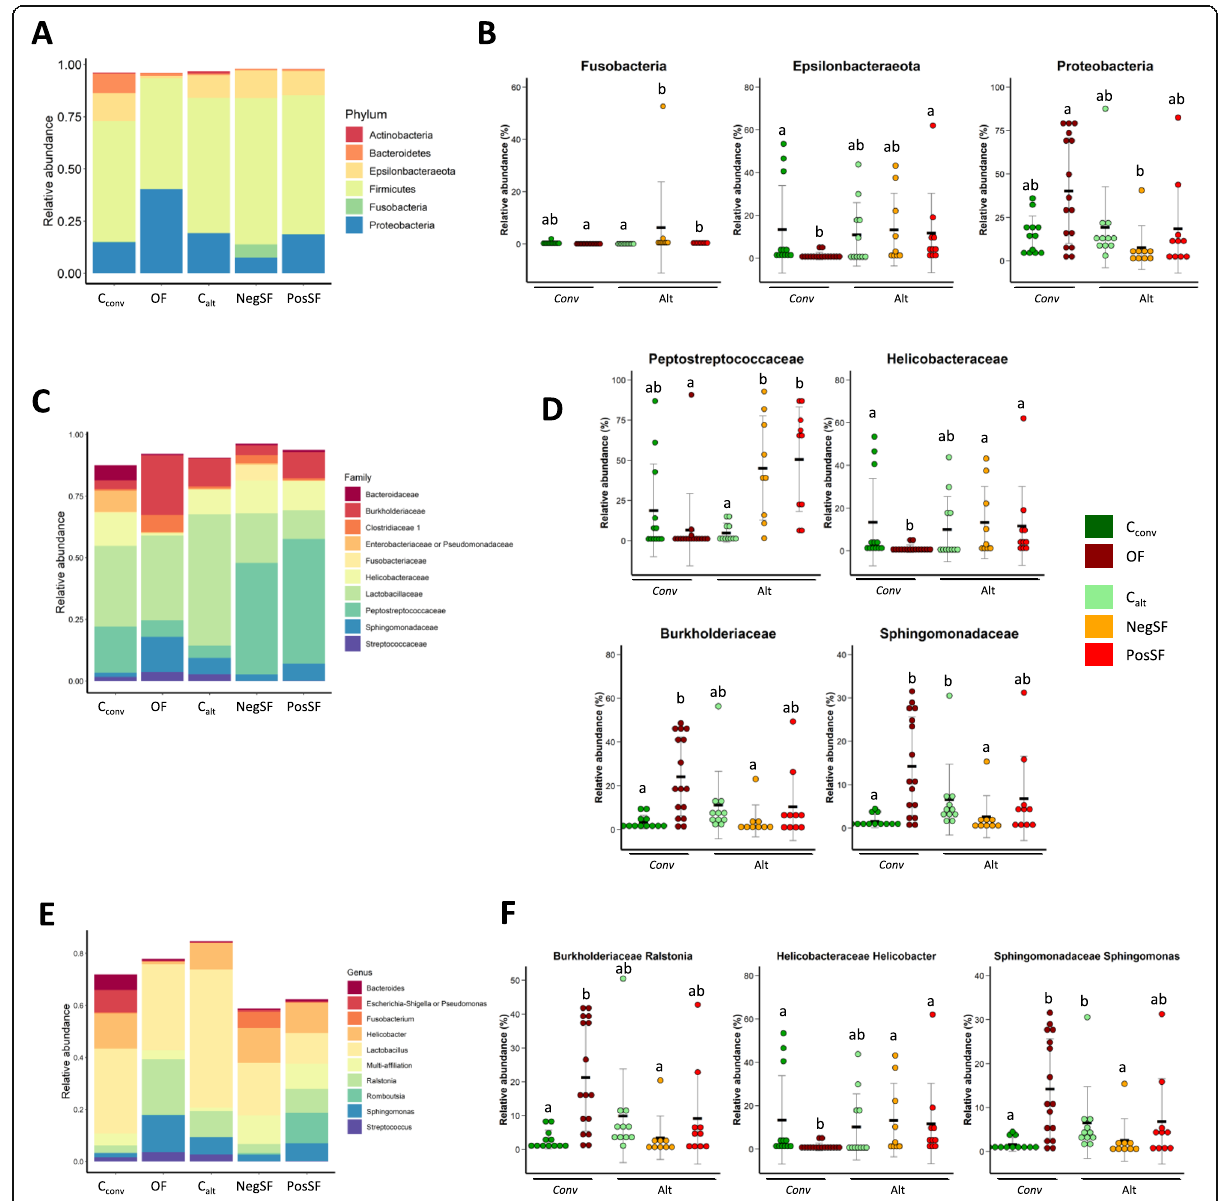
Fig. 5 Microbial composition according to the experimental groups at ( a-b ) Phylum, ( c - d ) Family and ( e - f ) Genus level. In panels ( c ) and ( e ) only the 10 most abundant Families ( c ) and Genera ( e ) are depicted. Means are presented by black horizontal lines and SD as grey error bars. Conv: Conventional breeding system, Alt: Alternative breeding system. C conv : Control group before overfeeding, OF: Overfed group, C alt : Control group before Ad libitum corn mixture feeding, NegSF: Negative response groupe to spontaneous fattening induction, PosSF: Positive response groupe to spontaneous fattening induction. Within a plot, groups with different superscripts differ ( P < 0.05) according to a Wilcoxon non parametric